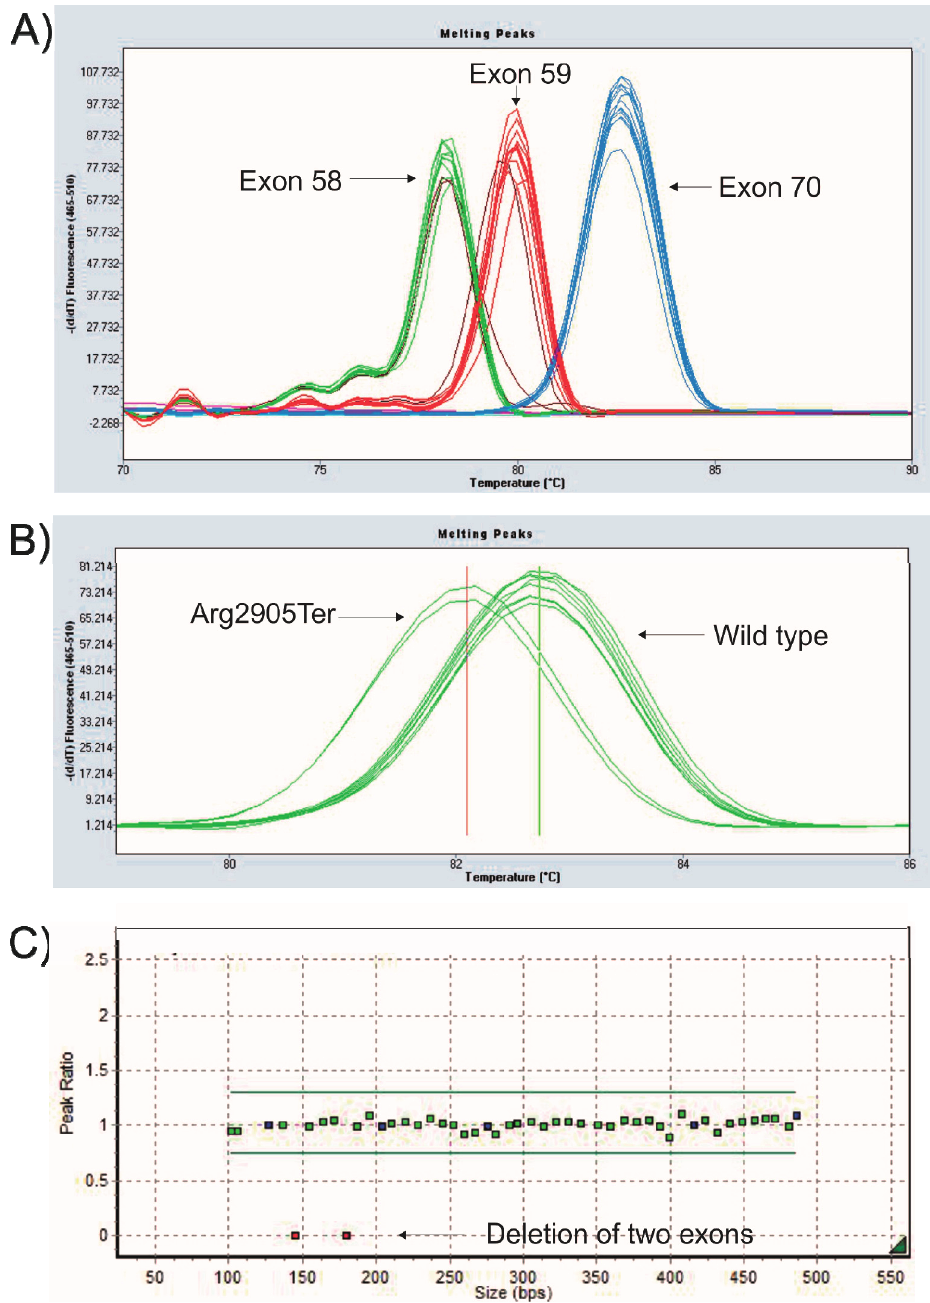
Figure 3. High Resolution Melting (HRM) and MLPA. ( A ) Melting peaks of the three exons that account for most frequent stop codon mutations in the DMD gene; ( B ) Melting peaks of a sample (duplicate) with a point mutation in exon 59 compared to a wild-type sample; ( C ) MLPA assay showing a deletion of two exons of the DMD